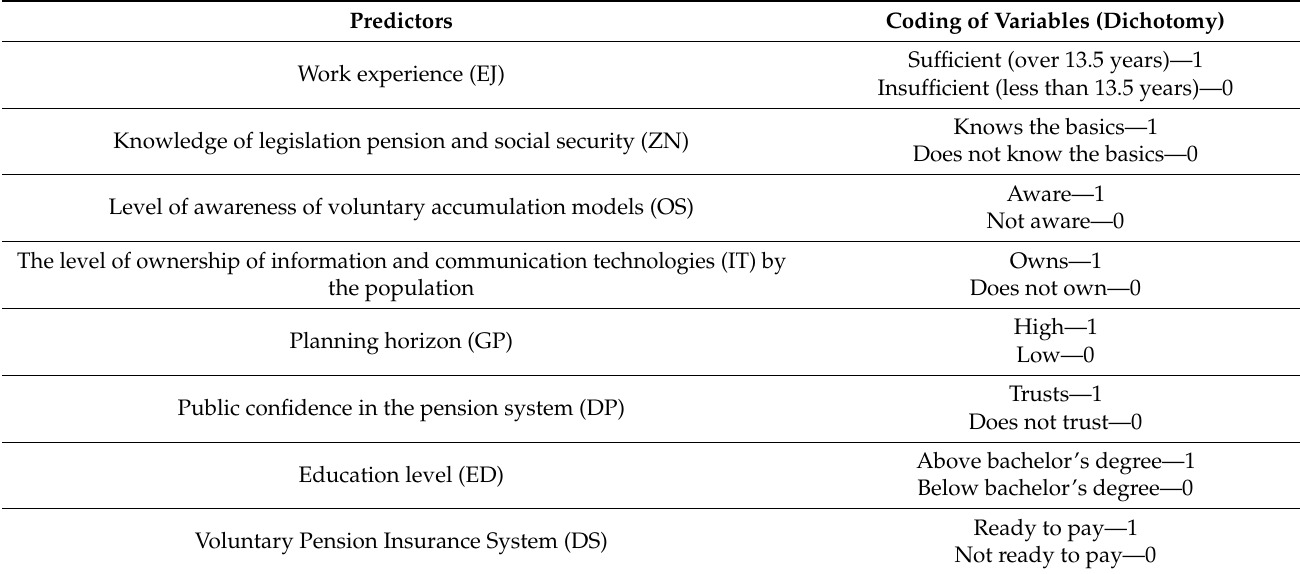
Table 1. Variables for the causality assessment model of